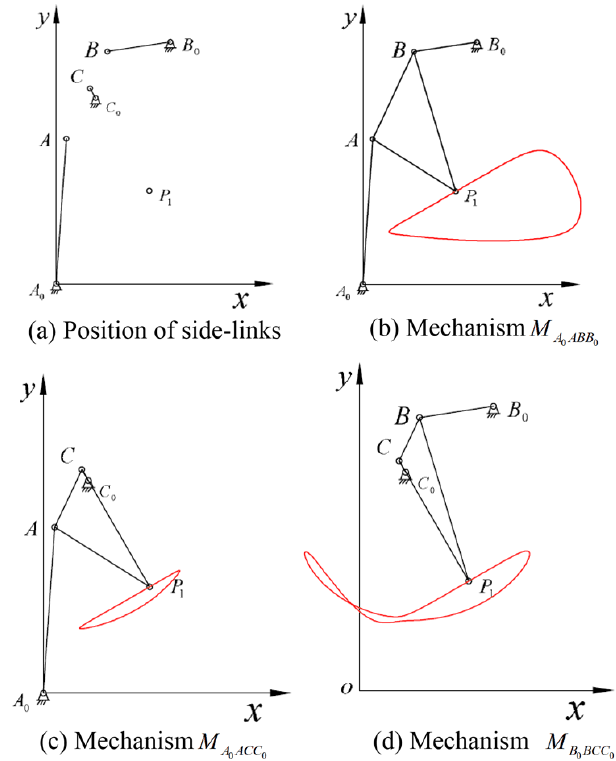
Figure 5. Synthesized